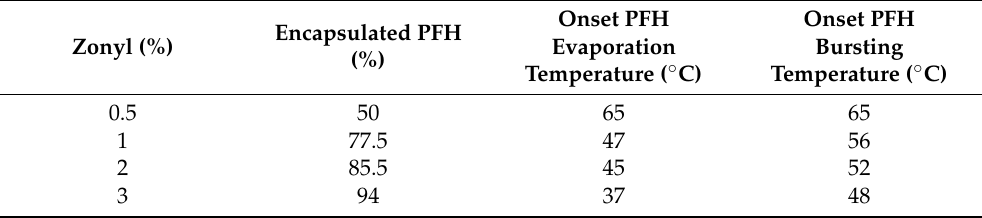
Table 3. Mass percentage, onset evaporation temperature, and onset bubble bursting temperature of encapsulated PFH as a function of Zonyl ® concentration.